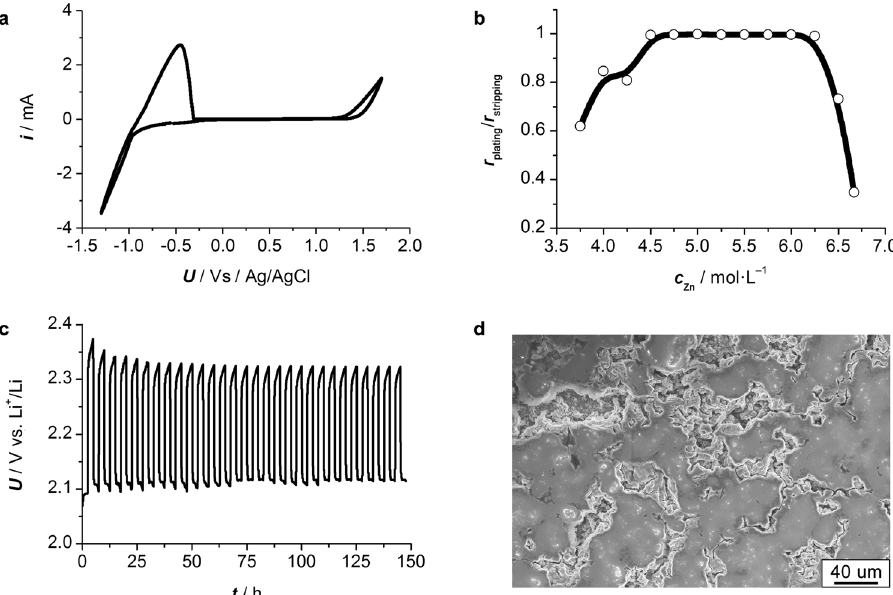
Figure 3. Electrochemical characterizations of 5 M Zn eutectic mixture | separator | Li half-cell. ( a ) Cyclic voltammogram profile recorded at a sweeping rate of 10 mV·s − 1 showing the electrochemical window of Zn eutectic mixture; ( b ) electroplating/electrostripping ratio ( r plating / r stripping ) versus ZnCl 2 concentration ( c Zn ) of Zn eutectic mixtures at room temperature. The cut-off voltage is set to 0.9–2.3 V vs. Li + /Li and the current density is set to 0.2 mA·cm − 2 ; ( c ) short-term cycling performance. The charging and discharging time is fixed to 2.5 hrs, and the current density is set to 0.2 mA·cm − 2 ; ( d ) SEM image showing the typical morphology of electroplated Zn on Zn foil in a fully discharged